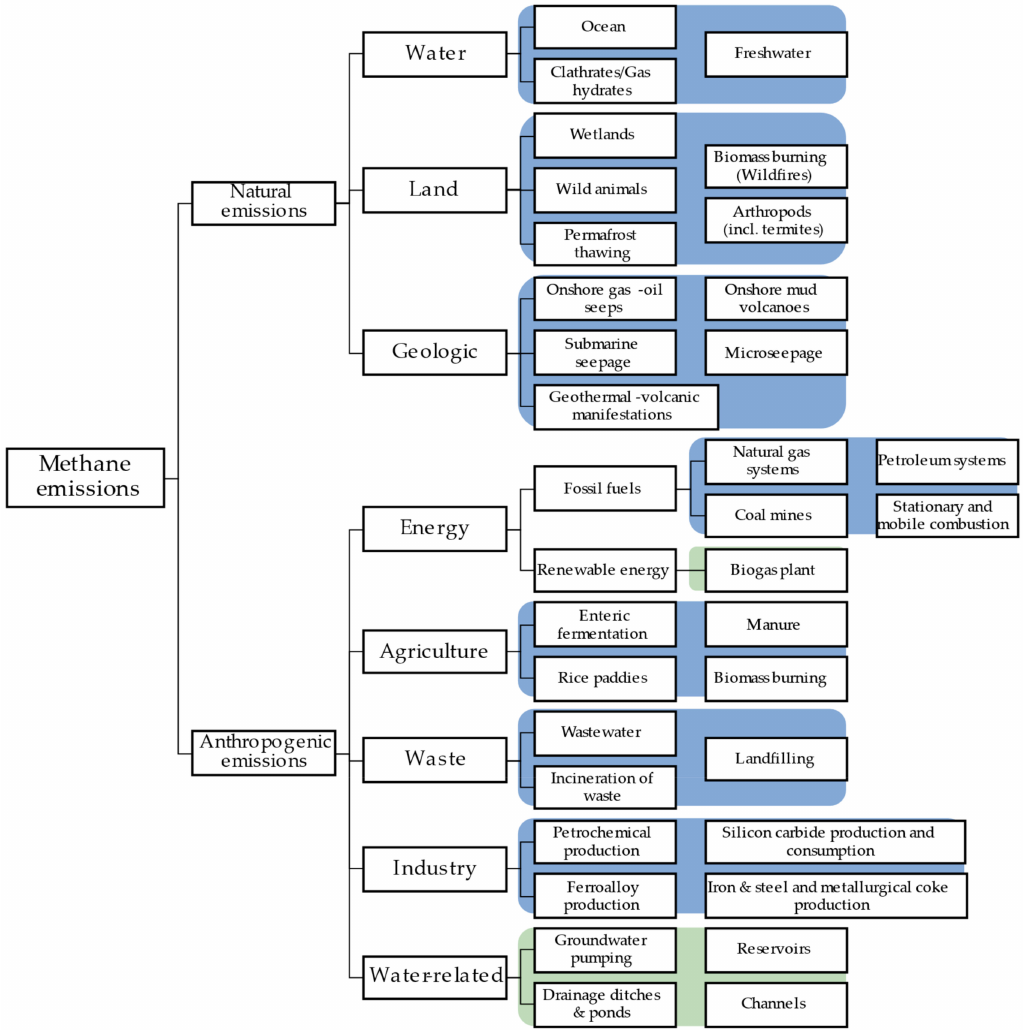
Figure 2. Categorization of methane emission sources. Blue indicates commonly used categories in literature, while green indicates new categories defined in the second part of this paper. Note that there are also other categorization approaches but the presented one focusing on sources seems particularly appropriate as a base for mitigation